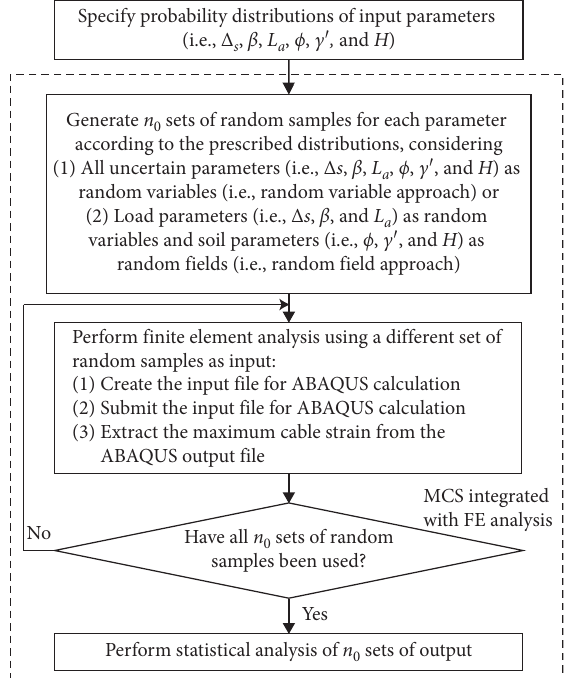
Figure 6: Probabilistic framework for assessment of parameter